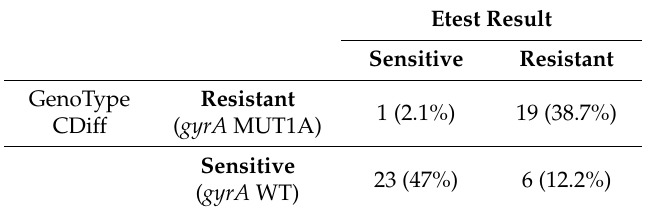
Table 3. Correlation of moxifloxacin resistance in accordance with GenoType CDi ff kit and